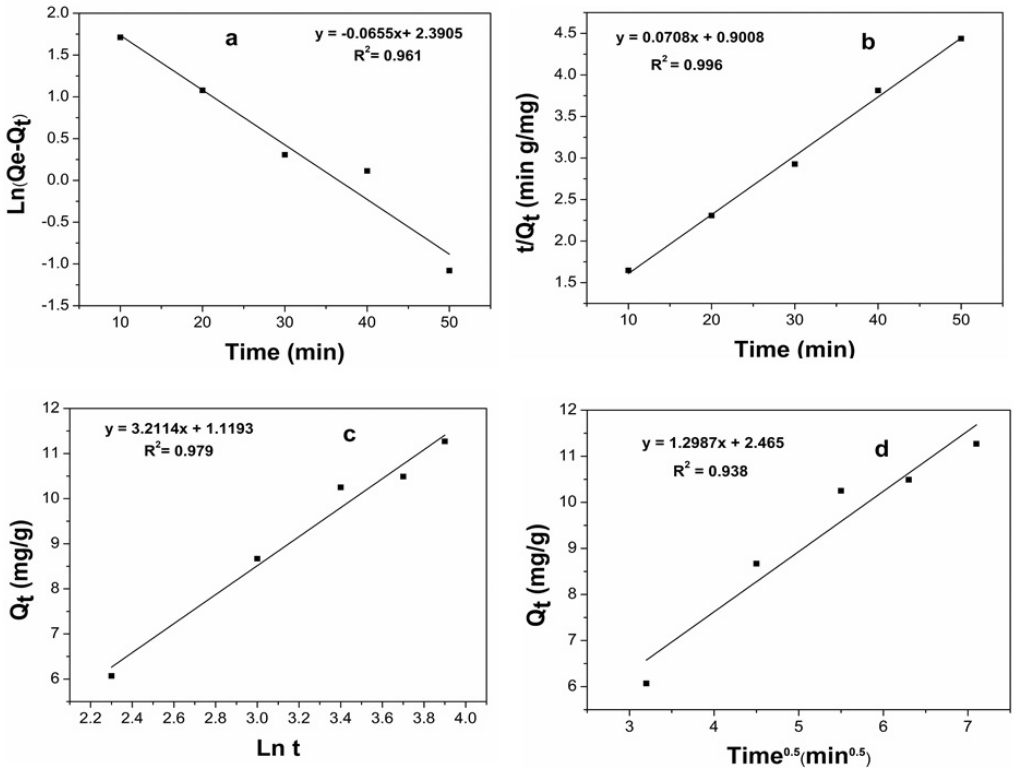
Fig. 10. Pseudo-first-order (a), pseudo-second-order (b), Elovich (c) and intraparticle diffusion (d) models for Mn (II) adsorption on OFIP adsor- bent.